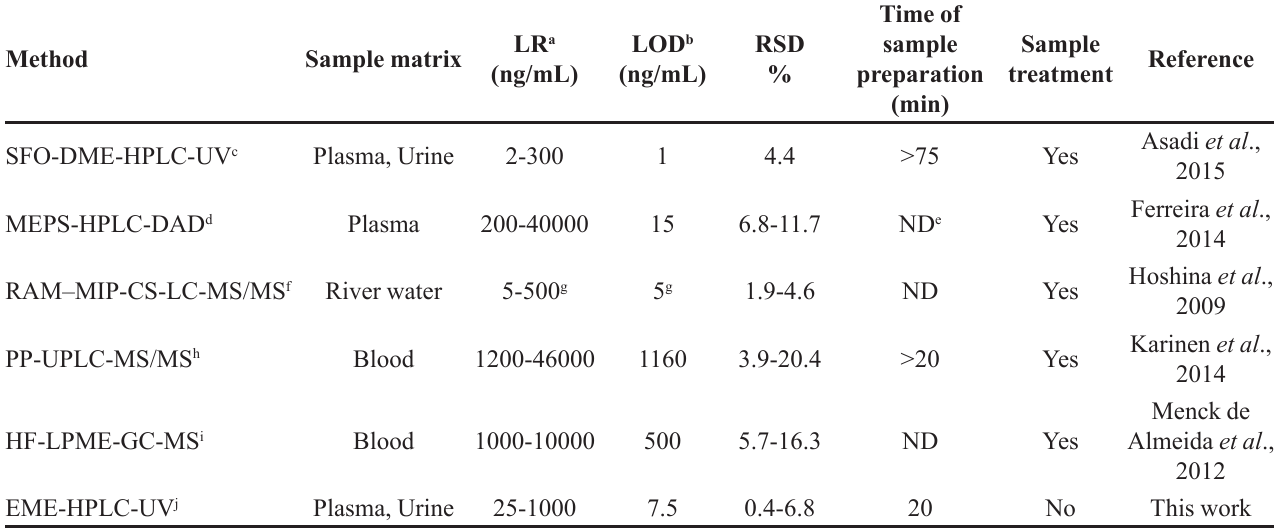
a Linear range; b Limit of detection; c Solidified floating organic drop microextraction-high performance liquid chromatography- ultraviolet detection; d microextraction by packed sorbent-high-performance liquid chromatography–diode-array detection; e Not defined; f restricted access media–molecularly imprinted polymer- column switching-liquid chromatography-tandem mass spectrometry; g ng/L; h Protein precipitation-ultra performance liquid chromatography-tandem mass spectrometry; i Hollow-fiber liquid-phase microextraction-gas chromatography-mass spectrometry; j Electromembrane extraction- high performance liquid chromatography-ultraviolet